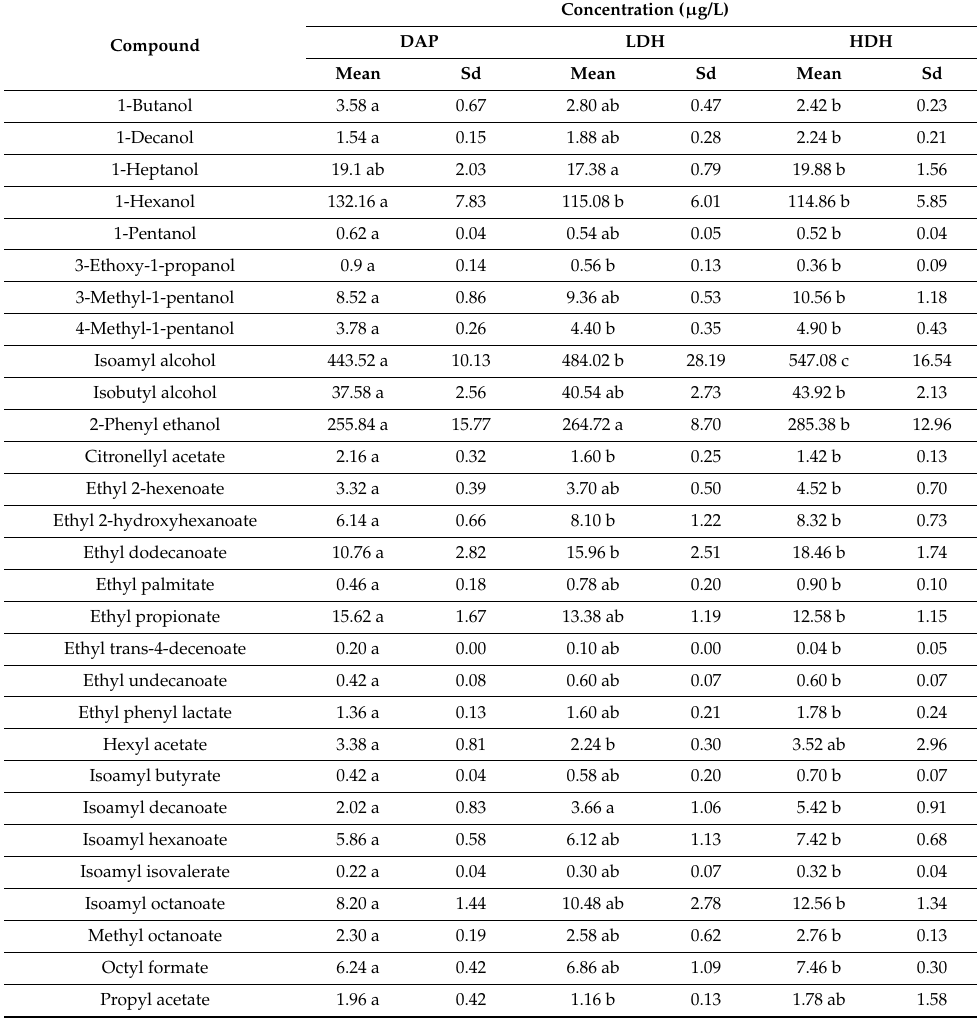
Table 1. List of significantly different volatile compounds for Cabernet Sauvignon wines with different nitrogen supplementations.